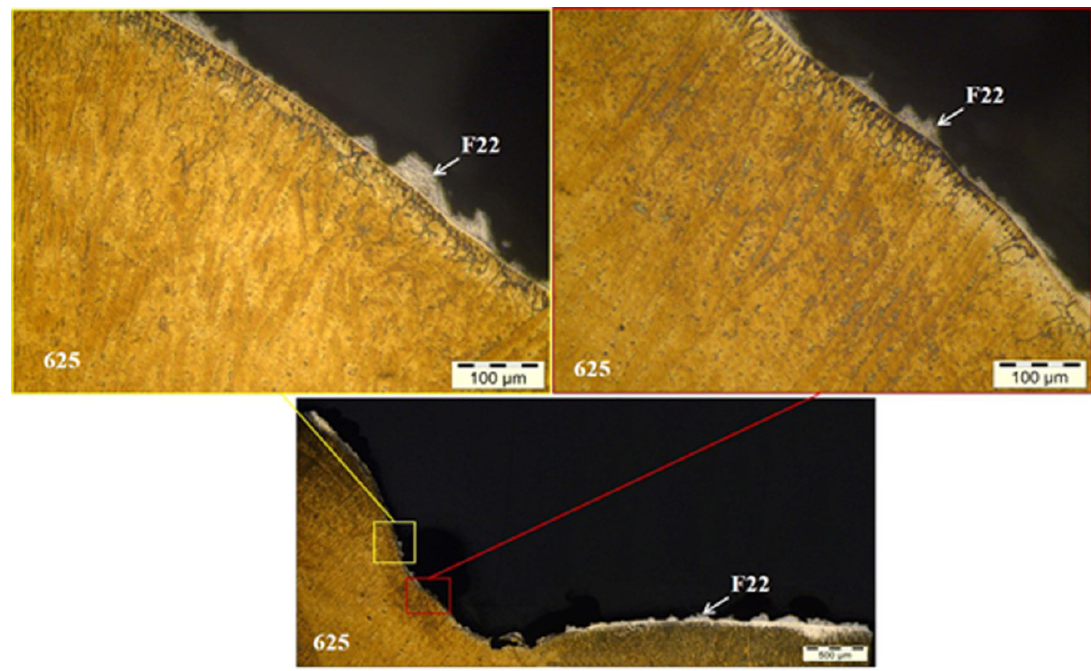
Figure 16. Optical microscopy of the cross section of the welded joint, steel ASTM A182 F22 - Inconel 625 - steel ASTM A36 with hydrogenation.